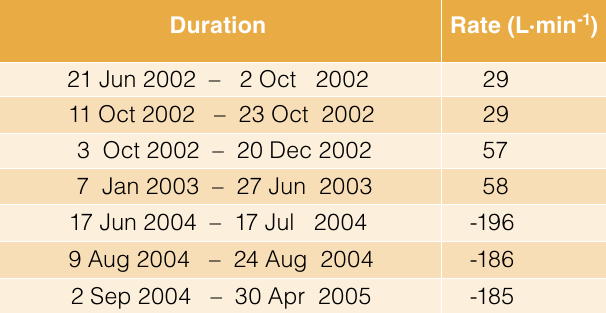
Table 1: Rough schedule of production and injection tests at KTB- VB (neglecting rate changes lasting 100 hours or less); negative rate: injection.